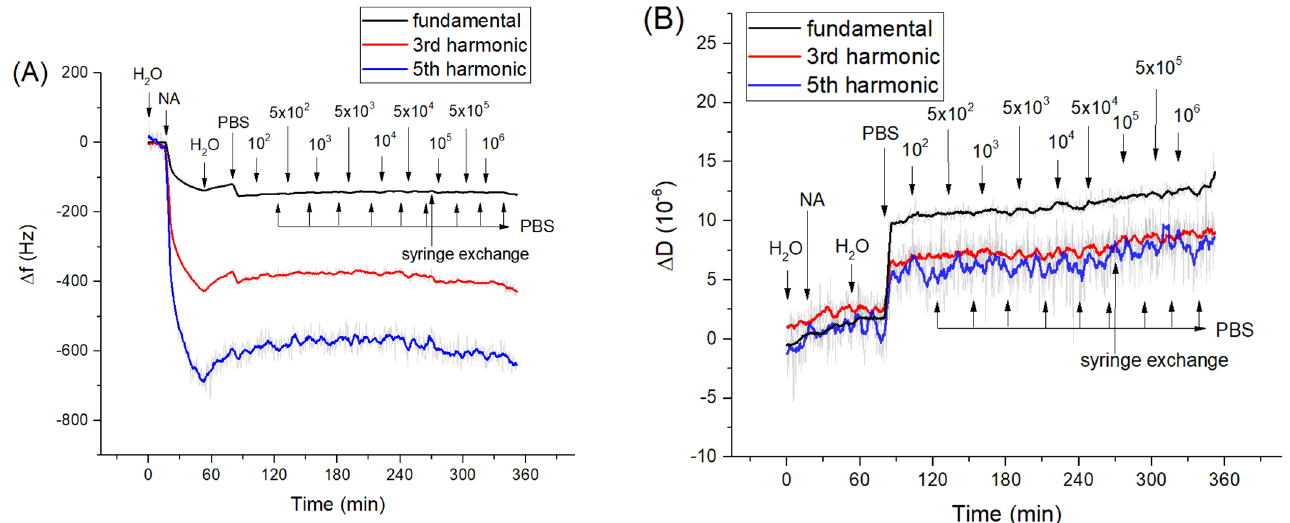
Figure 2. The kinetics of the changes of ( A ) fundamental frequency, 3rd and 5th harmonic frequencies and ( B ) dissipation vs. time following addition of Listeria innocua to the neutravidin layer. The moment of addition of neutravidin (NA), bacteria and washing of the surface by deionized water, PBS as well as exchange of the syringe from the syringe pump are shown by arrows. The syringe exchange caused a slight increase of dissipation at a fundamental harmonic.